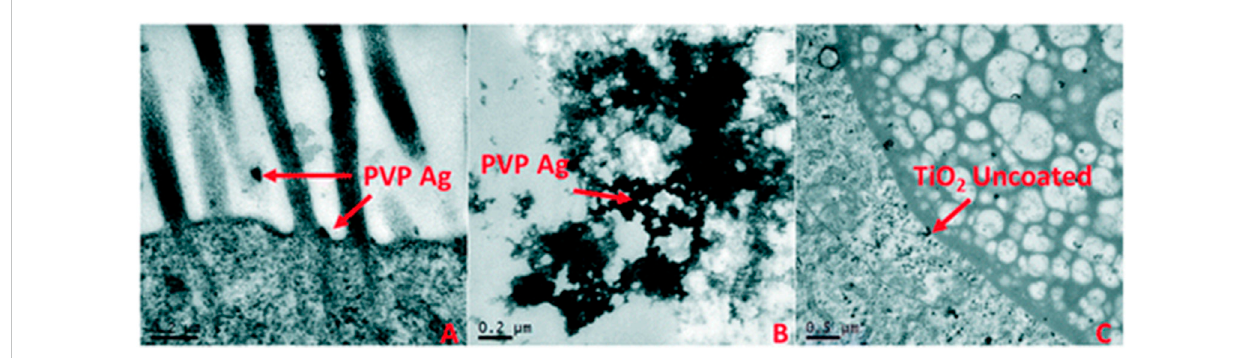
FIGURE 3 An example of the use of TEM images to determine the accumulation of NM in Daphnia guts and potential translocation. Uptake and localisation of (A) freshly dispersed PVP-coated Ag NMs in HH combo medium showing microvilli interactions, (B) freshly dispersed PVP-coated Ag NMs in HH combo found in the gut lumen space; and (C) freshly dispersed uncoated TiO 2 NMs in HH combo, showing evidence of NM translocation in the bush border. Reproduced from (Ellis and Lynch, 2020) with permission from the Royal Society of